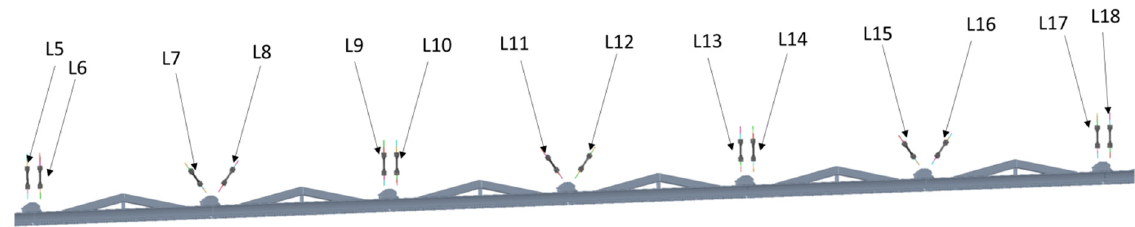
Figure 11. Marking and numbering of suspensions with force sensors in the computational model. Moreover, emergency braking was simulated in two variants, differing in the value of the braking force. In the first simulation variant, emergency braking with full force of braking devices was used. In the second variant, the braking force was reduced by 50%. Such an approach was aimed at emphasizing the high impact of the braking method on the forces loading the route suspensions while increasing the speed of the monorail. The maximum tensile forces in each suspension, recorded during the simulation of emergency braking at different speeds, are presented in Tables 2 and 3. In the tables, each cell is divided into two parts by a dashed line. The upper part (above the dashed line) shows the results of the simulation of braking at 50% of the braking force, while the lower part of the cell (under the dashed line) shows the values obtained in the simulations with full braking force. Table 2. Maximum forces in suspensions recorded during simulation of emergency braking at different travel speeds (suspensions L5-L11). Speed [m/s]/Simulation